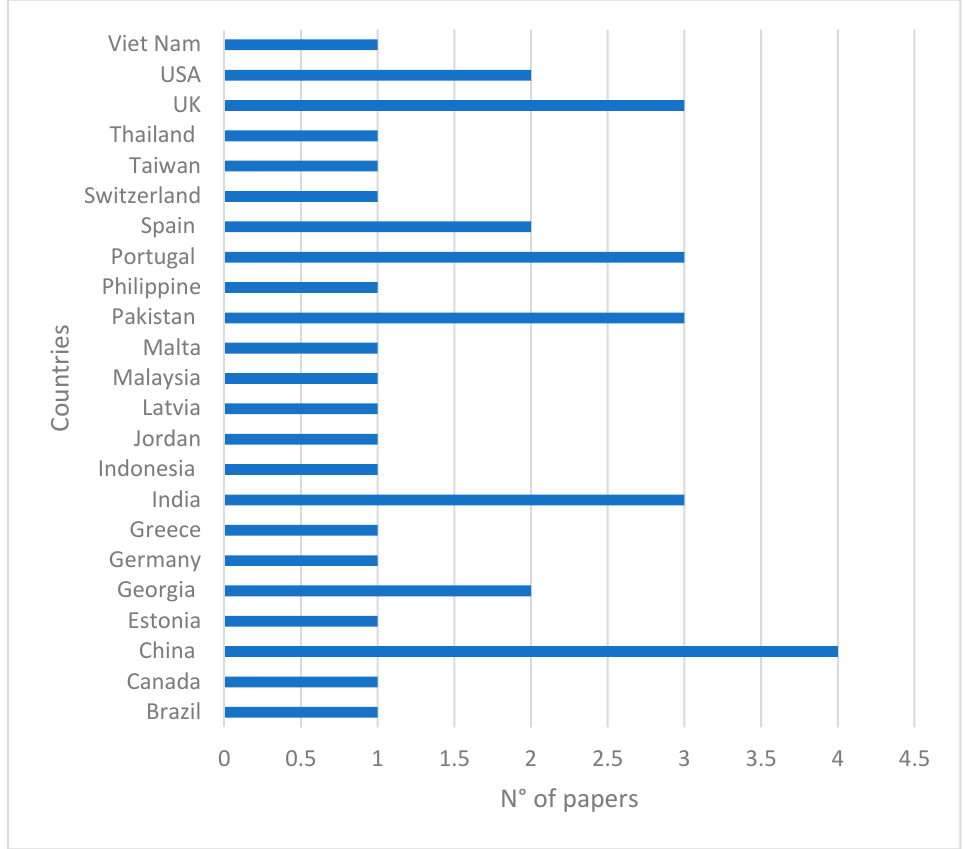
Figure 3. Author’s country (prototypes).